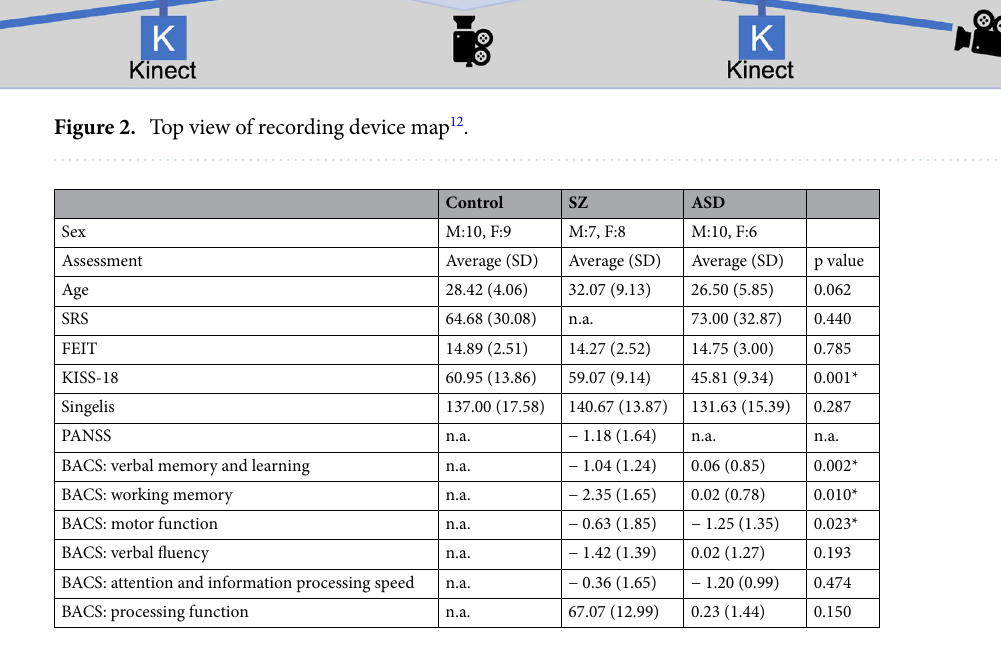
Table 1. Dataset statistics: we used one-way ANOVA as the statistical test, where * indicates significant differences